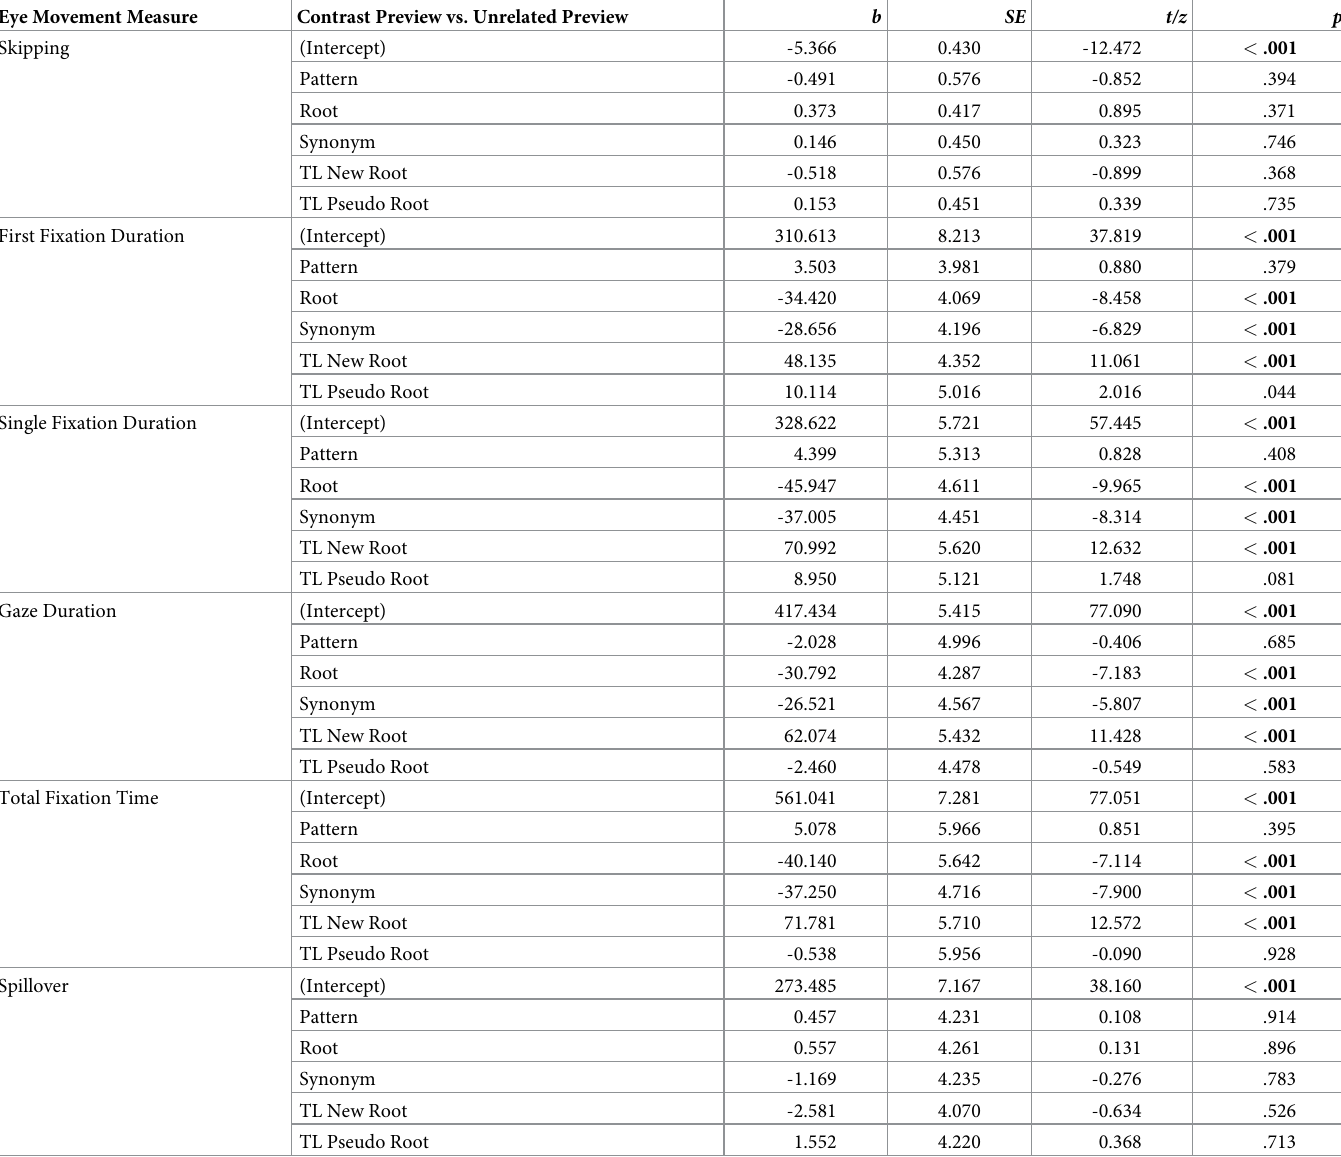
Table 4. Linear mixed models outputs for the contrast matrix of measures with unrelated preview as baseline. Eye Movement Measure Contrast Preview vs. Unrelated